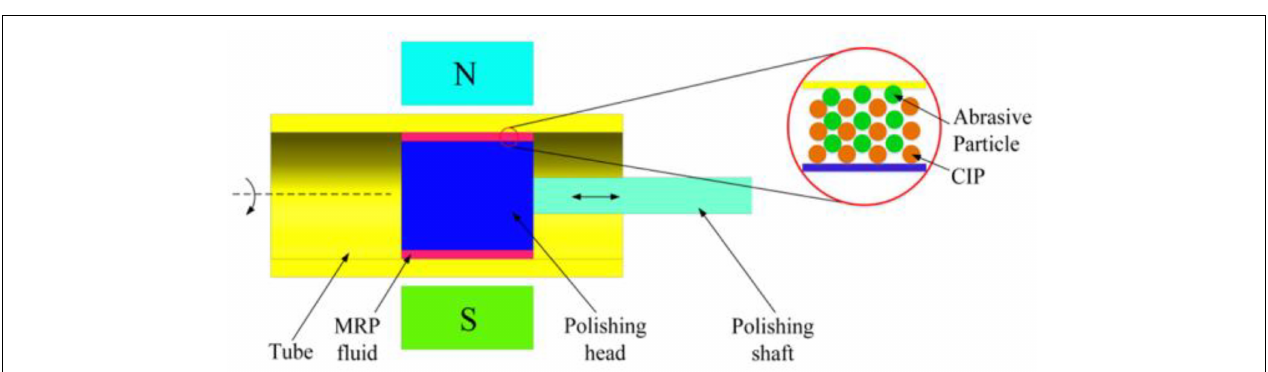
FIGURE 11 | MRF finishing with dynamic magnetic fields (Bin, 2019).